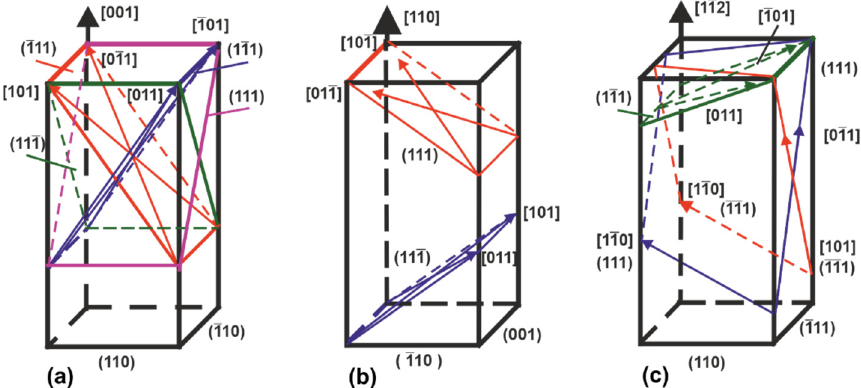
Figure 2. The orientation schemes of single crystals slip systems (panels ( a – c ) differ in the direction of the deformation axis and the orientation of the lateral faces, which are indicated in the sub ‐ pic ‐ tures).